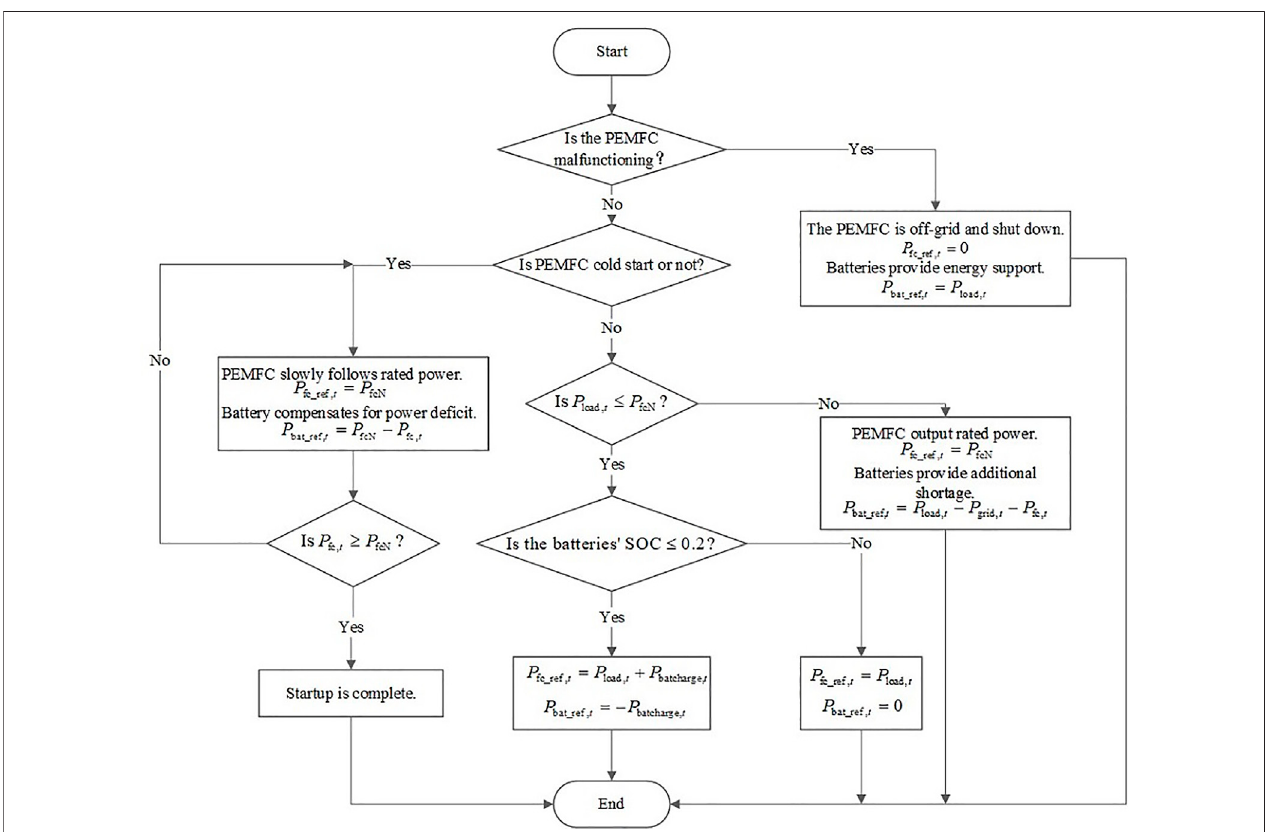
FIGURE 4 | Energy management fl ow